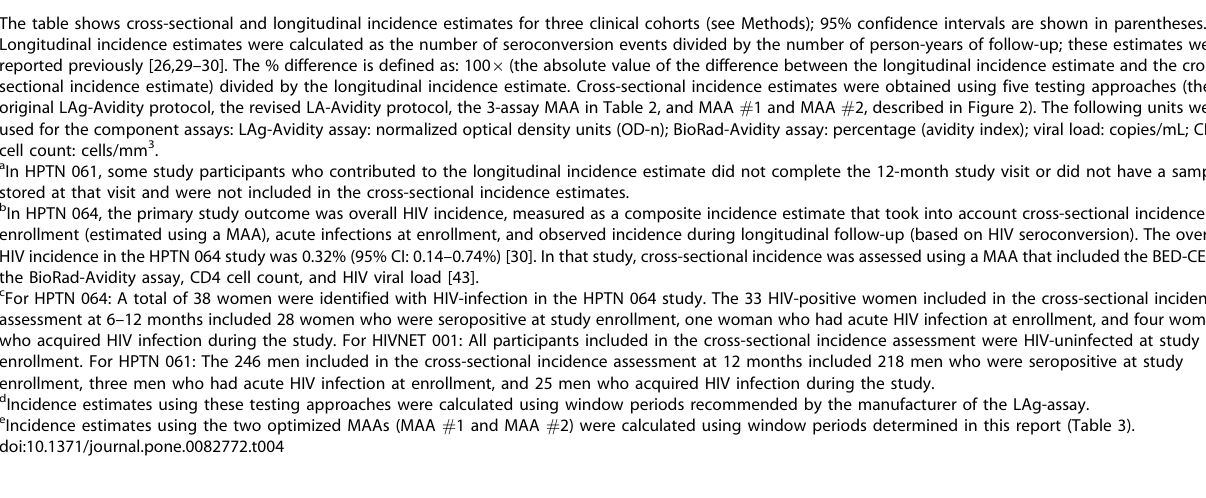
Method used to estimate